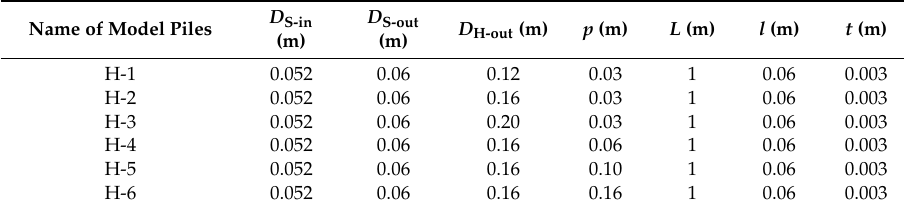
Figure 4. Photograph of the model piles. ( a ) Pipe pile and helical piles with different outer diameters (D H-out ). ( b ) Pipe pile and helical piles with different p. Table 1. Parameters for the model piles used in